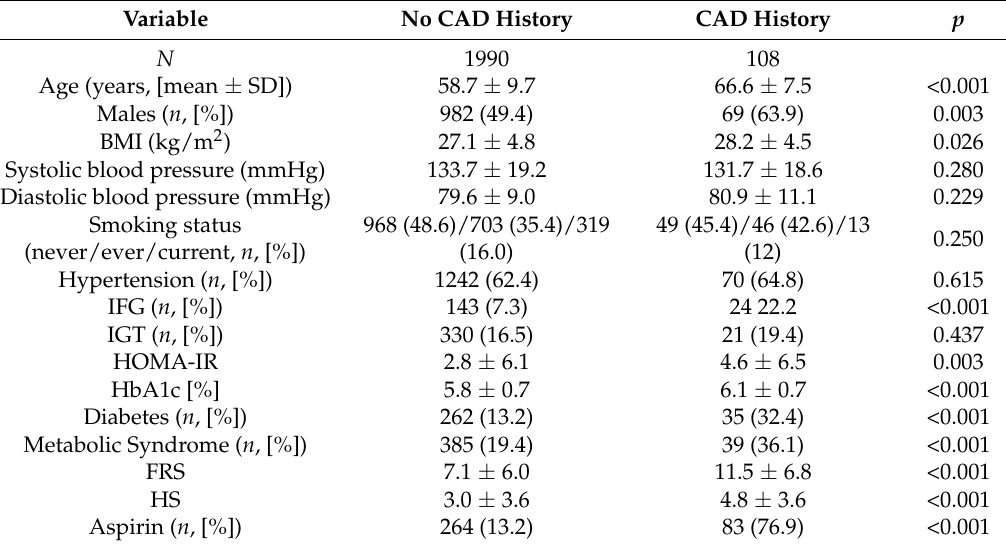
Table 1. Characteristics of subjects with and without CAD